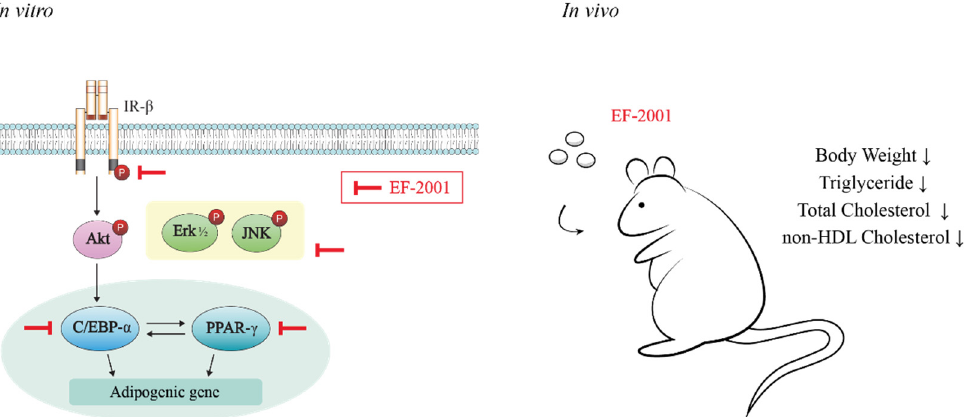
Figure 8. Schematic diagram of anti-obesity activity of EF-2001 on 3T3-L1 adipocytes and HFD-induced obese rats.